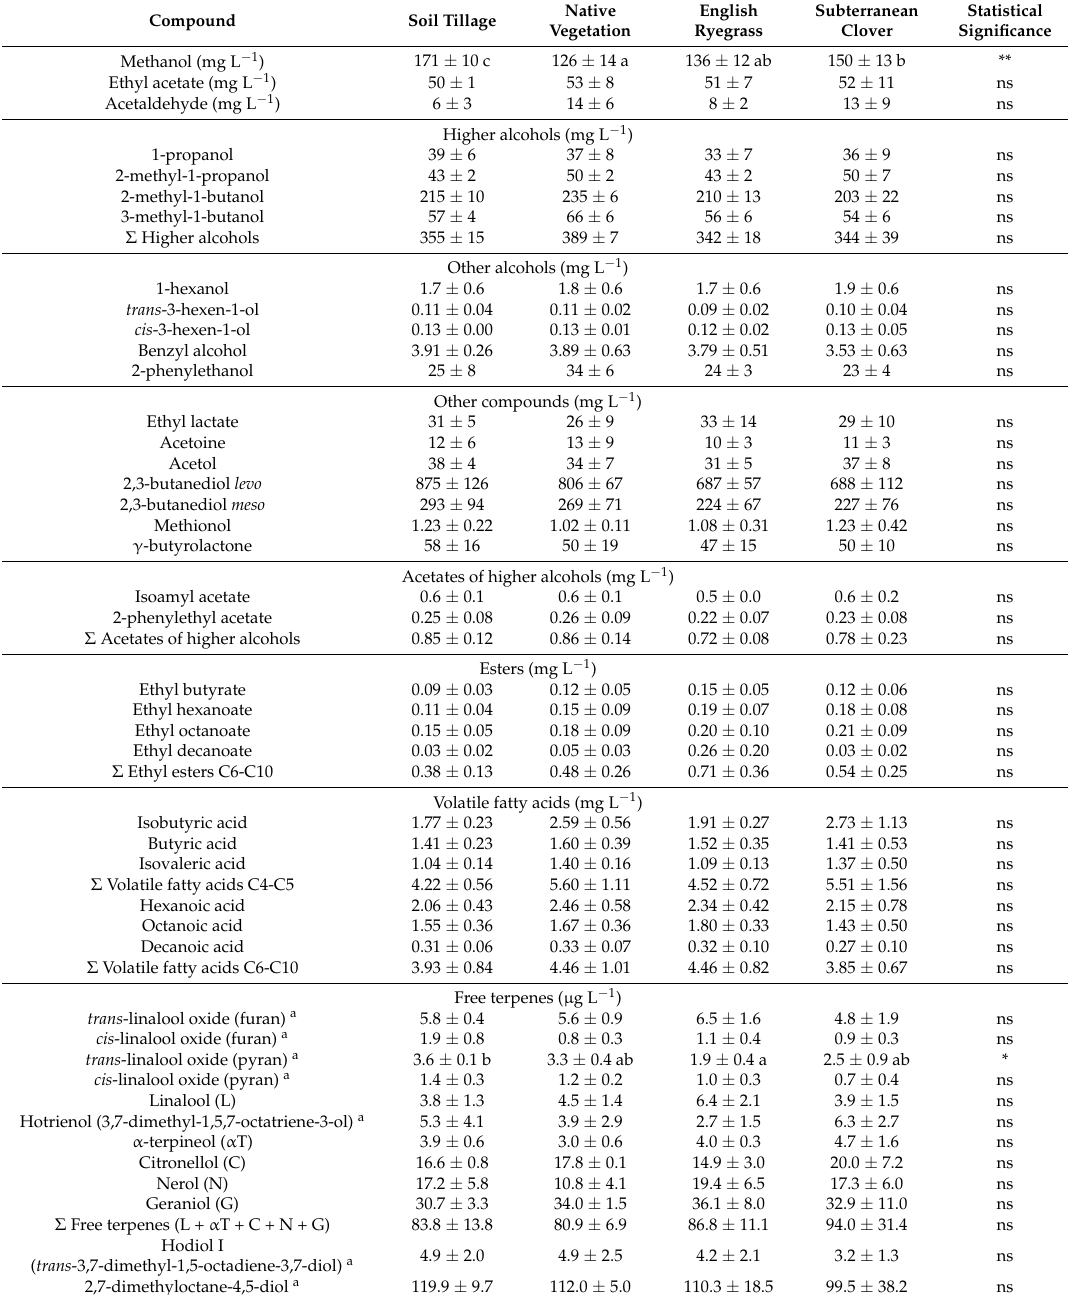
Table 5. Soil management effects on the concentrations (mean ± standard error) of volatile compounds in wines from Menc í a averaged for three seasons